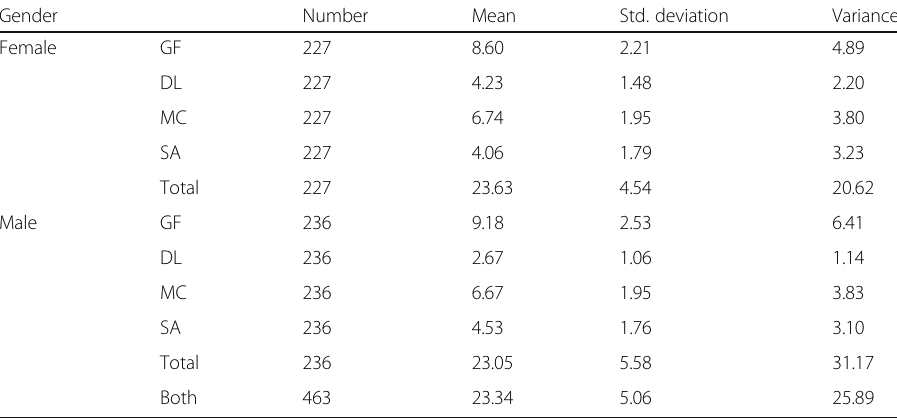
Table 4 Descriptive statistics for performance on the main test Gender